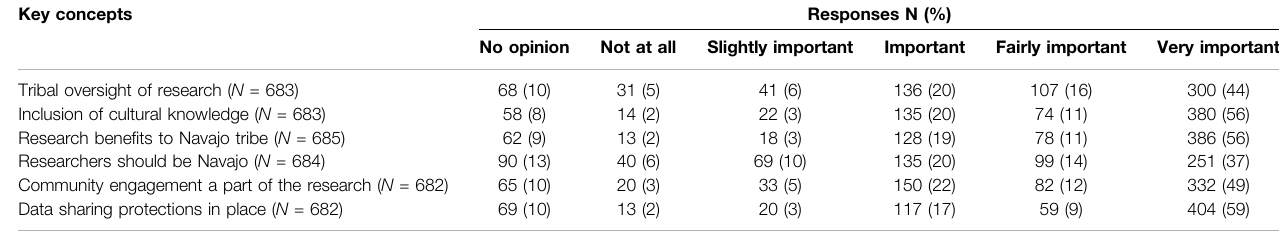
TABLE 4 | Importance of factors for a genetic research policy. Key concepts Responses N (%)